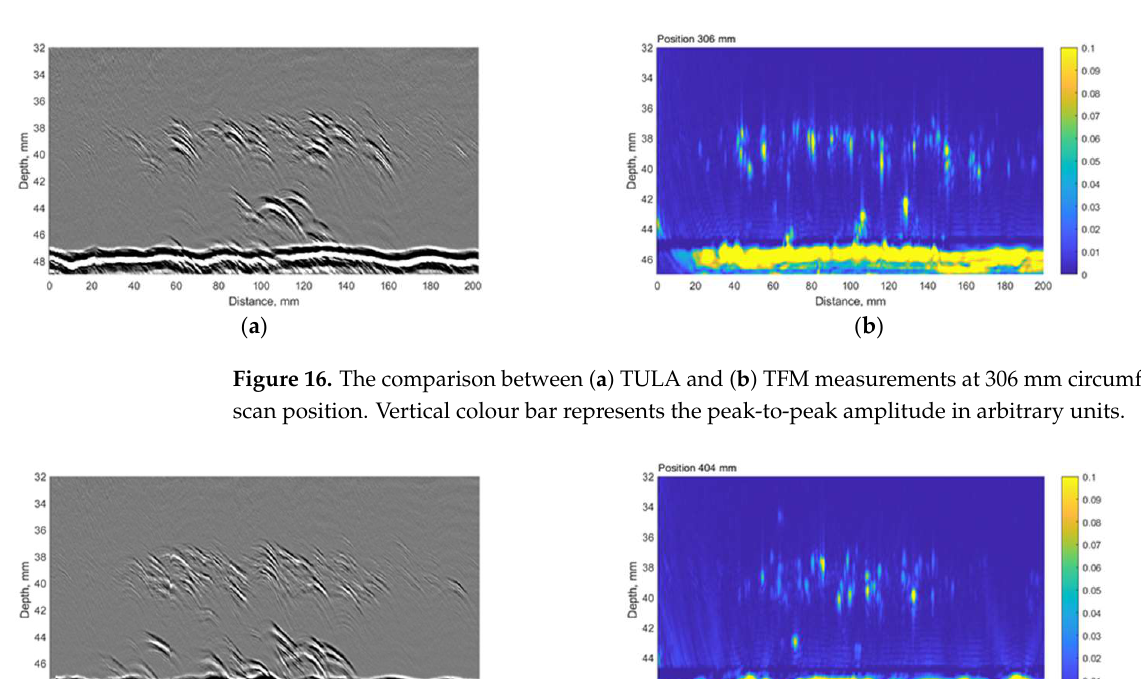
Figure 15. The comparison between ( a ) TULA and ( b ) TFM measurements at 255 mm circumferen- tial scan position. Vertical colour bar represents the peak-to-peak amplitude in arbitrary units.